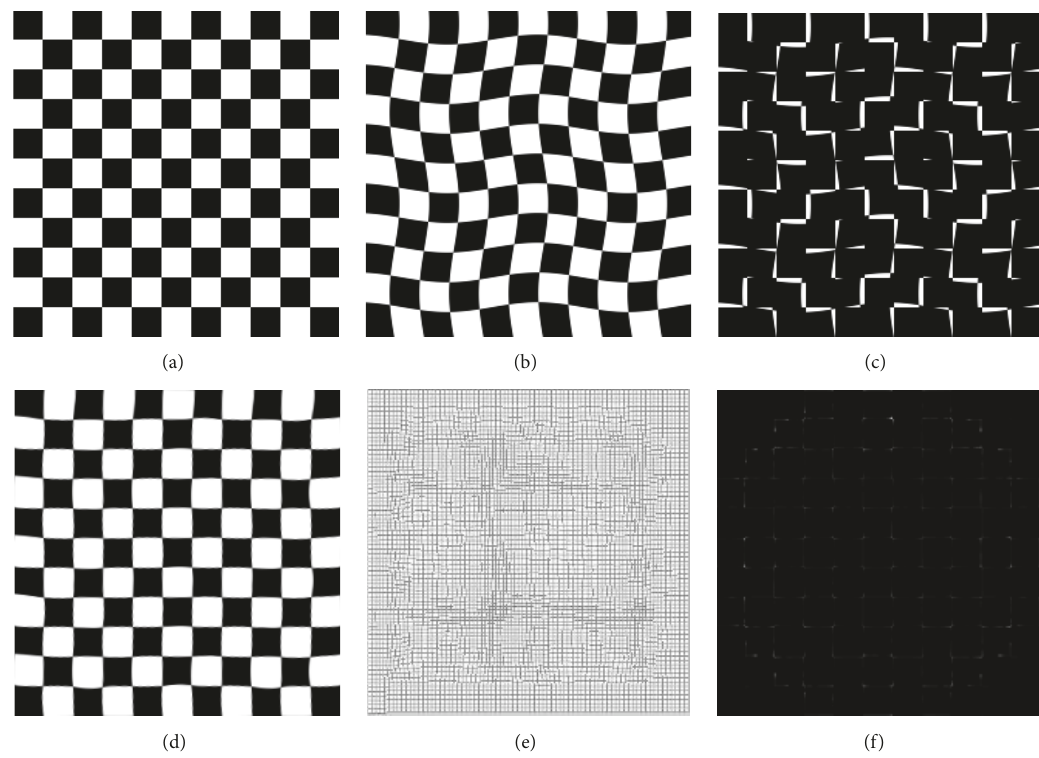
Figure 3: Results of checkboard image. (a) Reference image, (b) moving image, (c) initial difference, (d) registration result, (e) deformation, and (f) difference after registration.